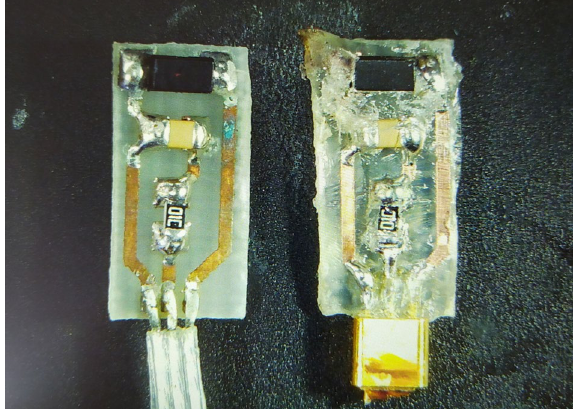
Figure 6. Corrosion comparison (PDMS on the left, epoxy with hermetic feedthrough on the